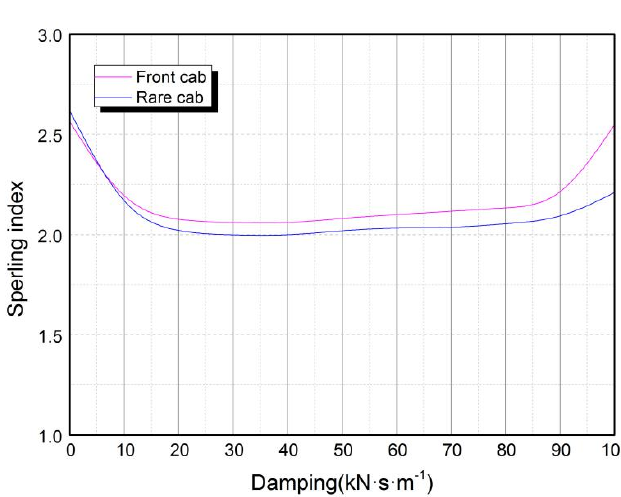
Figure 1. Sperling index versus lateral damping.